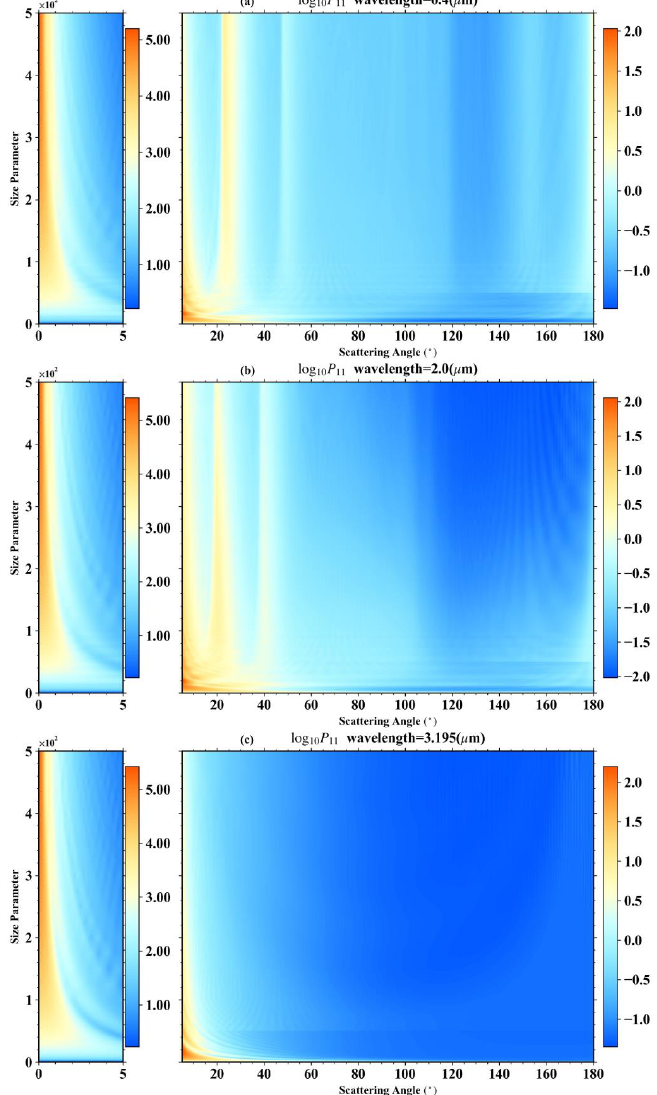
Figure 8. Scattering phase function trends for size parameters of 0.5 – 500. The refractive index of ice corresponds to incident wavelengths of 0.4 μ m ( a ), 2.0 μ m ( b ), and 3.195 μ m ( c ). Wavelengths plotted separately due to the differences in magnitude between forward and backward angles.